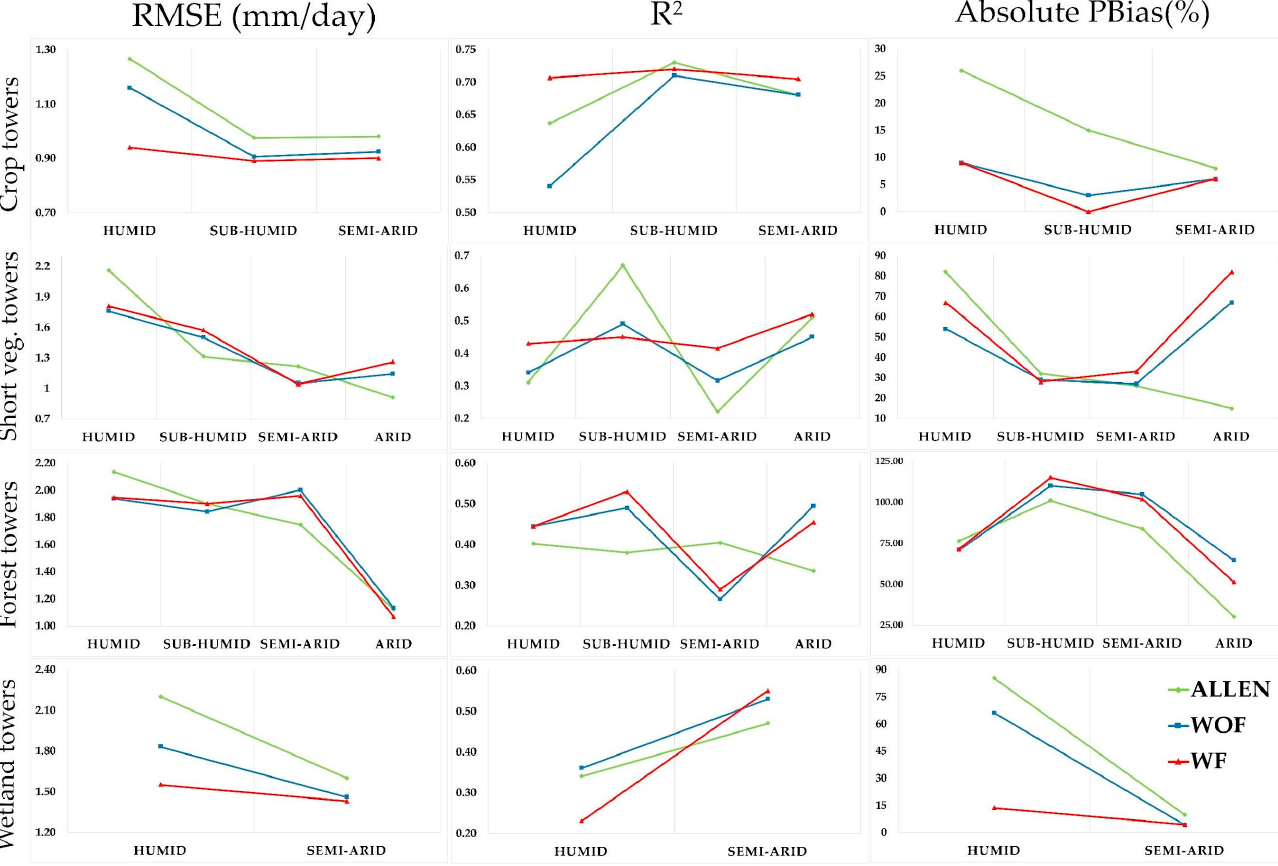
Figure A6. Trend of automated ET estimation performance based on both climate and land cover type.